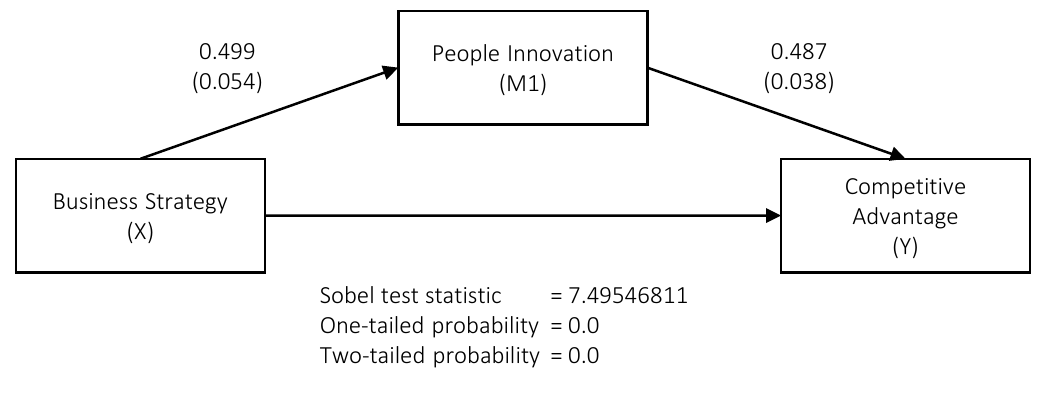
Figure 3. Sobel test results for H3